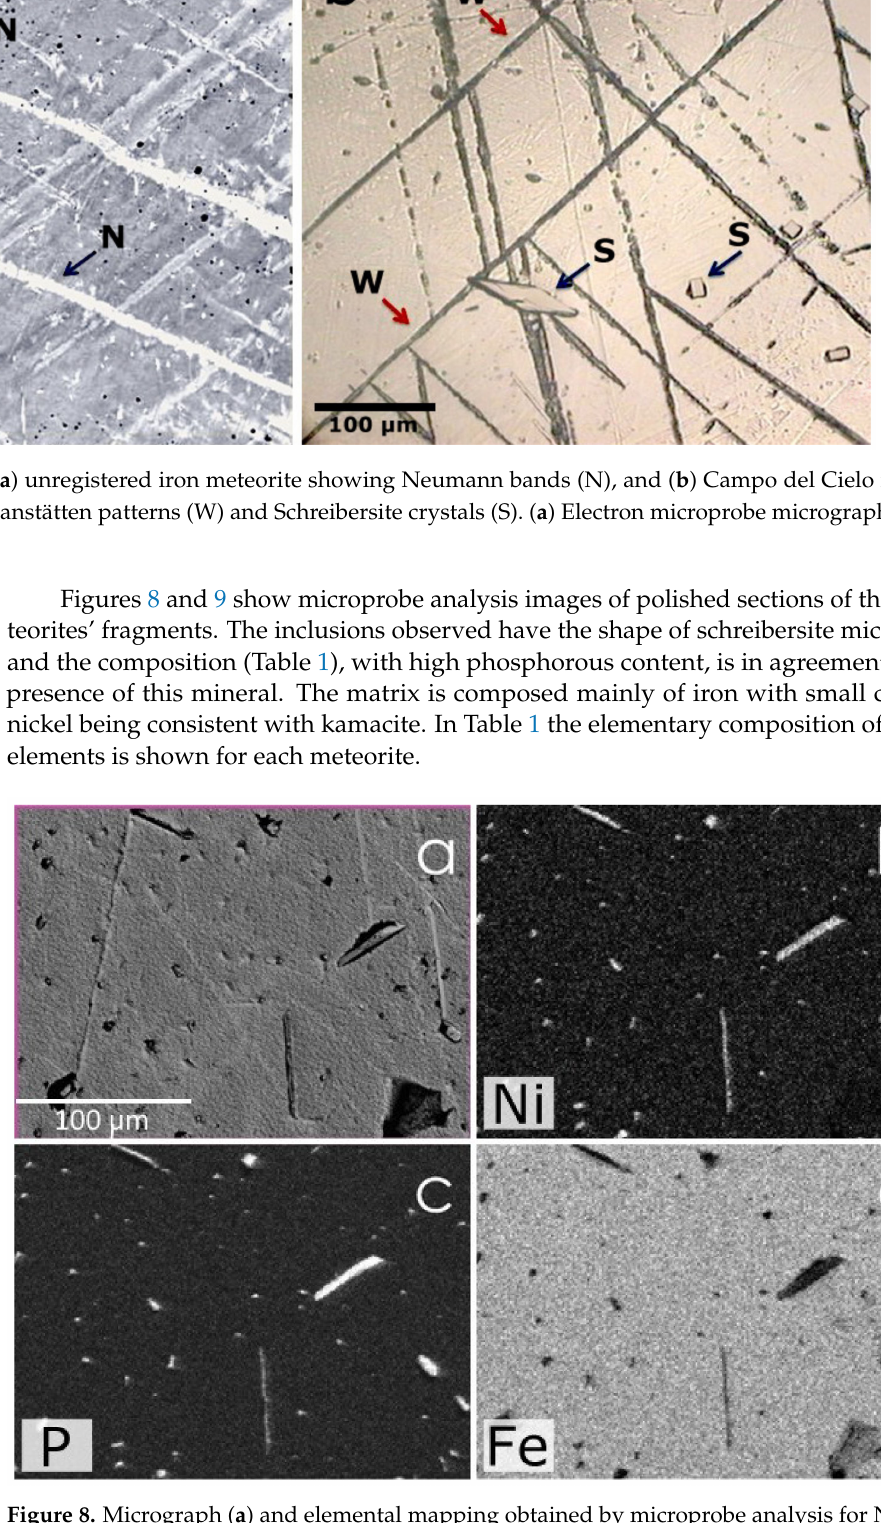
Figure 8. Micrograph ( a ) and elemental mapping obtained by microprobe analysis for Ni ( b ), P ( c ) and Fe ( d ) for the Find 1 iron meteorite